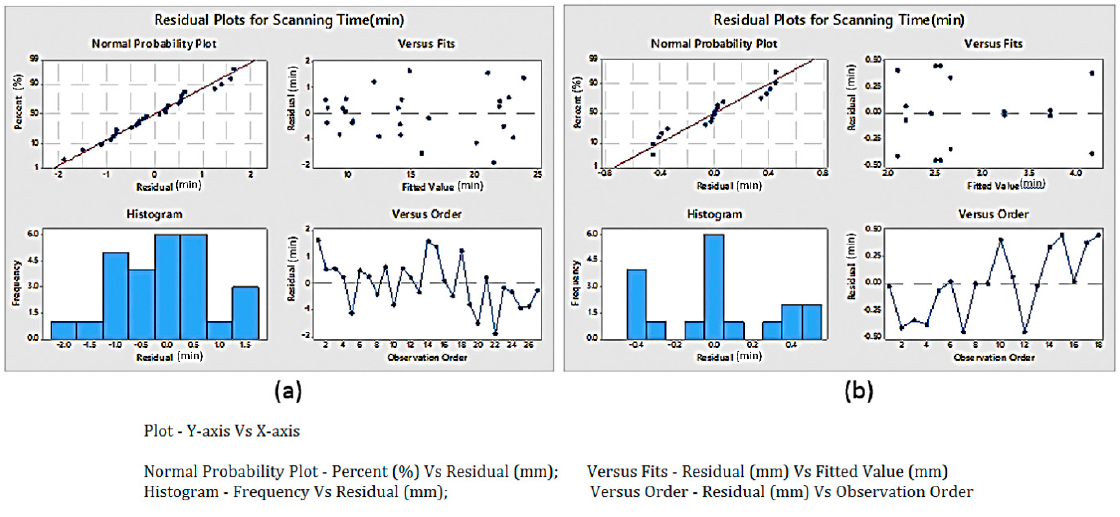
Figure 12. Normality test for scanning time ( a ) laser scanner; ( b ) white light scanner.